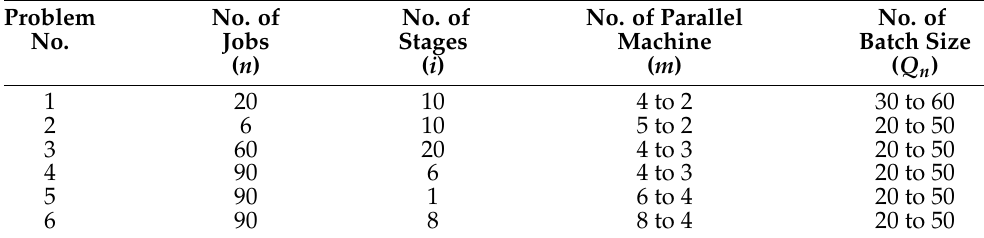
Table 7. Features of considered large size